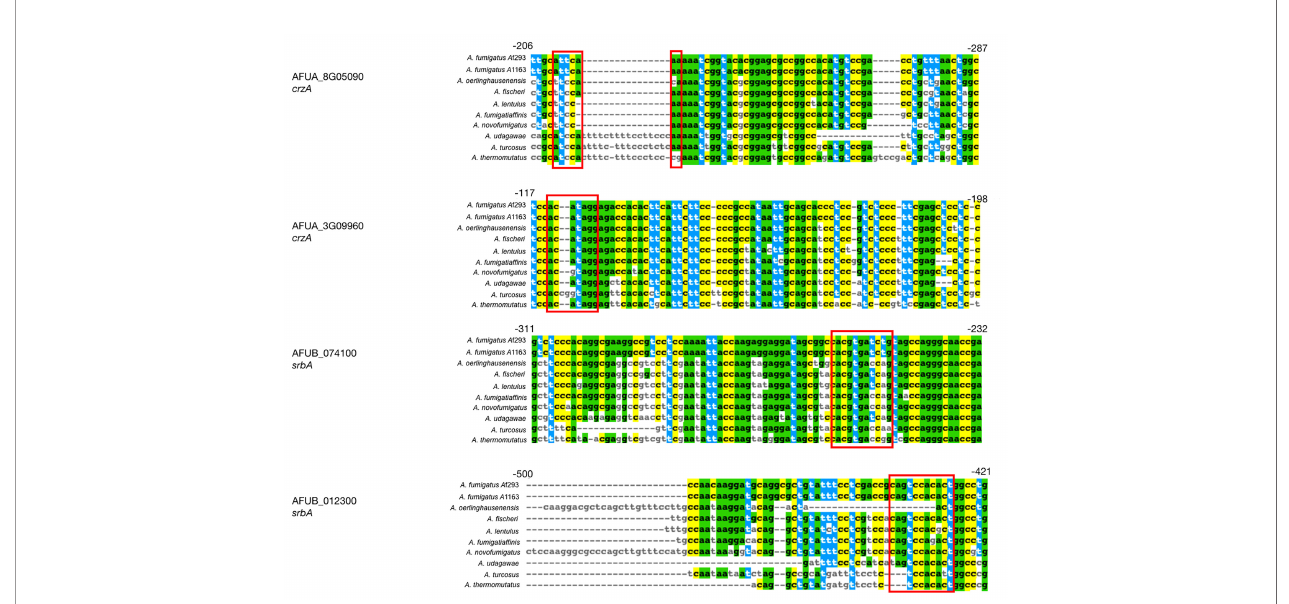
FIGURE 4 | CrzA and SrbA binding locationsin4 genes that exhibita different evolutionary rate intheir non-codingregions. Two A. fumigatus genes ( AFUA_8G05090 and AFUA_3G09960 ) knownto bind CrzA in their non-coding regionsand two A. fumigatus genes ( AFUB_074100 and AFUB_012300 ) known to bind SrbA intheir non-coding regions have at least a 2 bp difference inthe TFbinding site between A. fumigatus andone or morerelatives. Red boxes represent the binding site locationsfound inprevious ChIP-seq